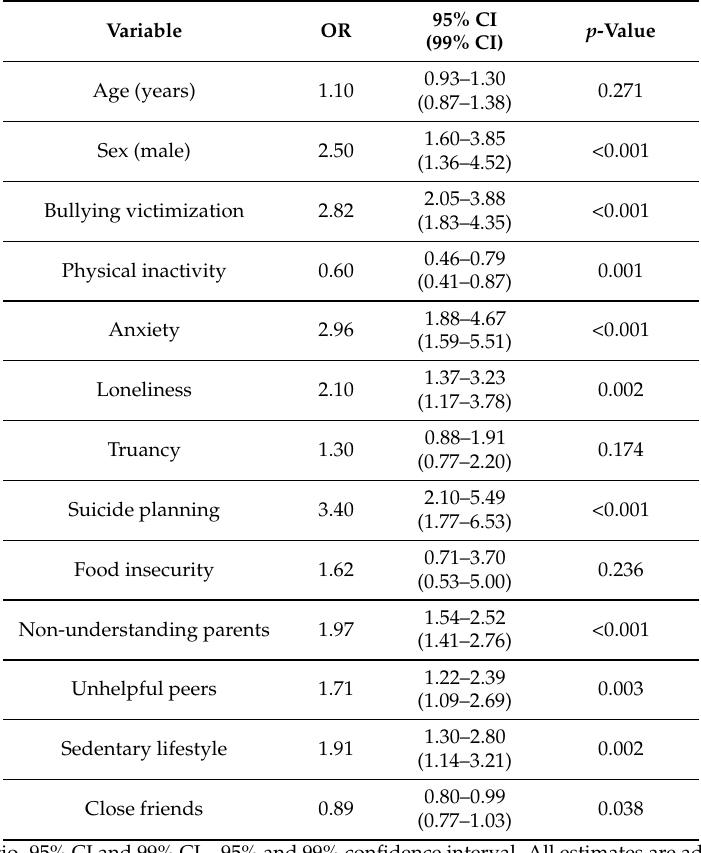
Table 3. Multivariate analysis of physical fighting among school-attending adolescents in El Salvador, GSHS